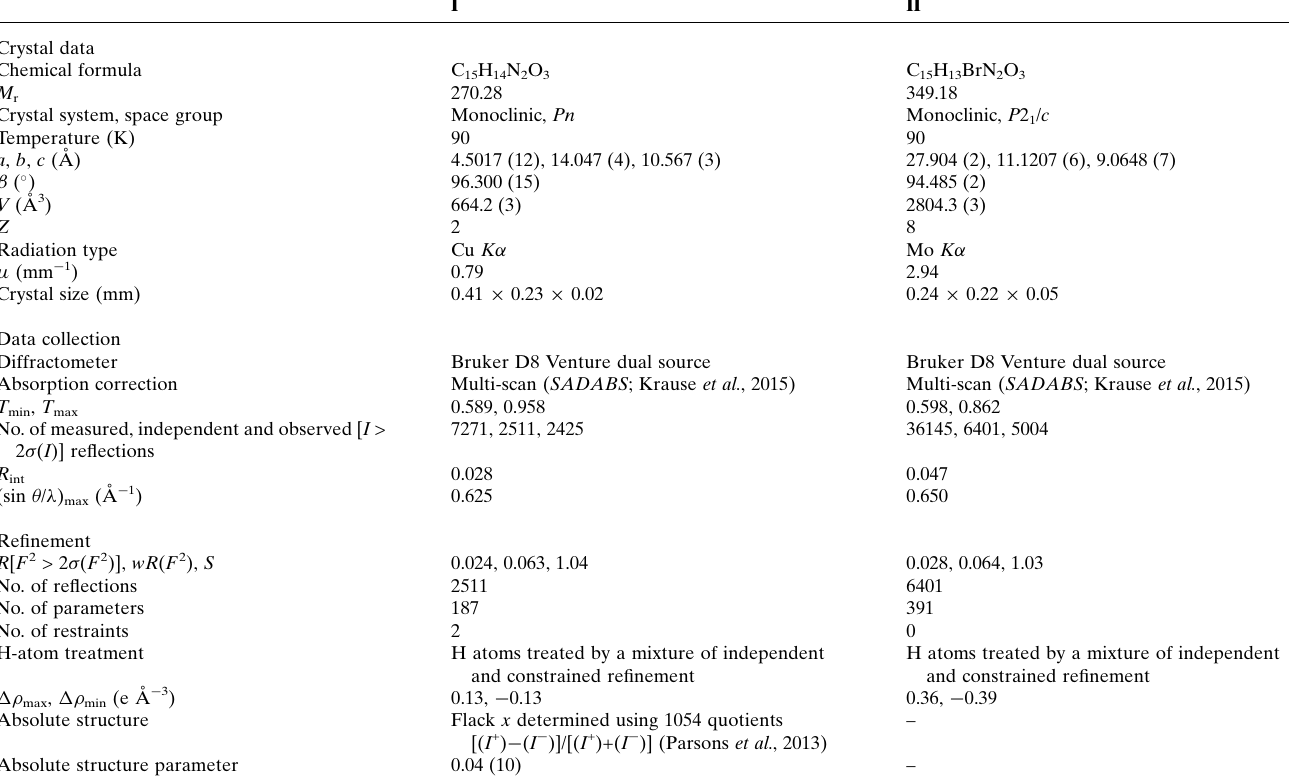
Table 5 Experimental details.